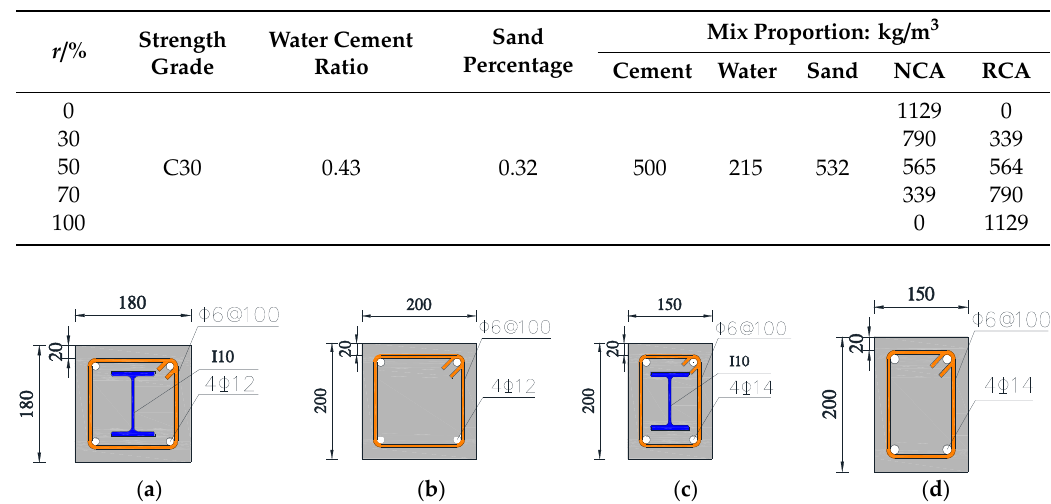
Table 1. Mix proportion of recycled concrete.